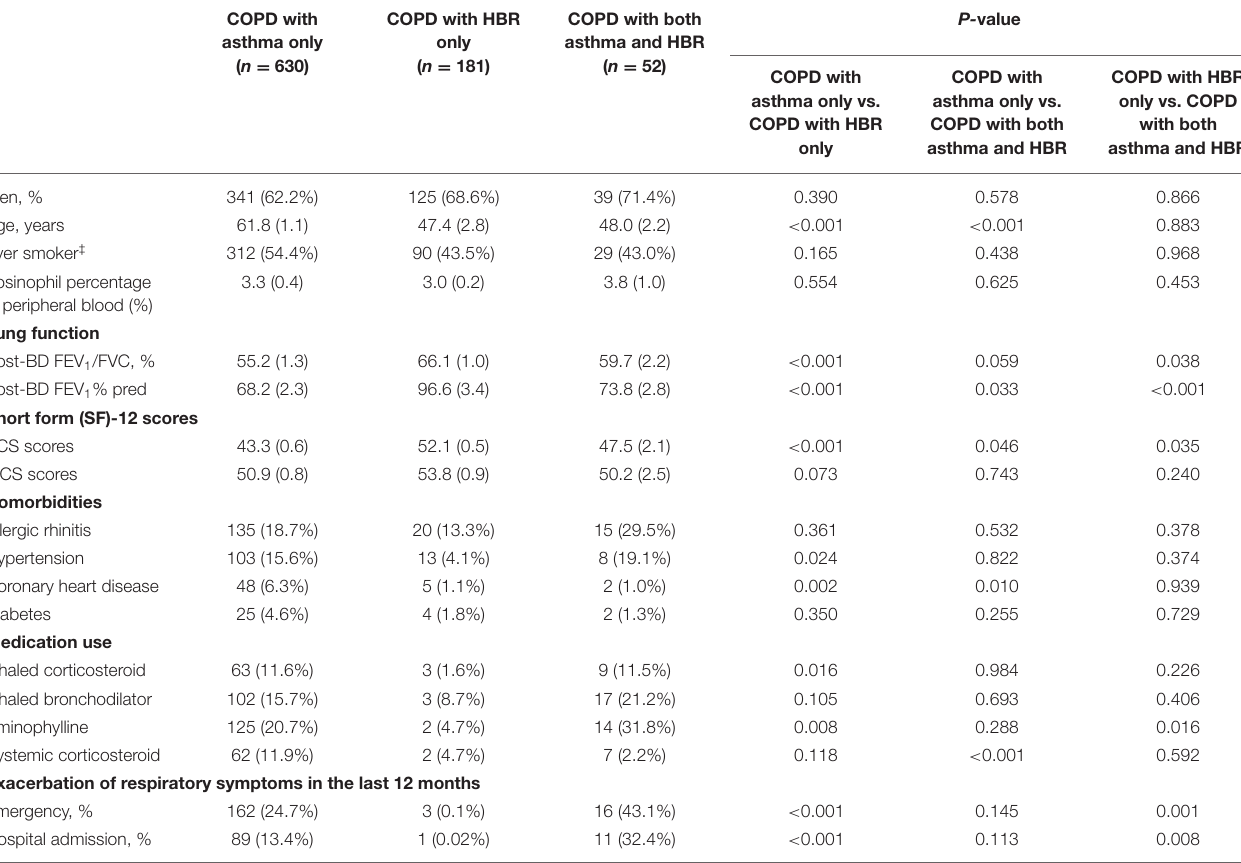
TABLE 4 | Comparison of clinical characteristics among the three subtypes of COPD with concomitant features of asthma in the general adult population.